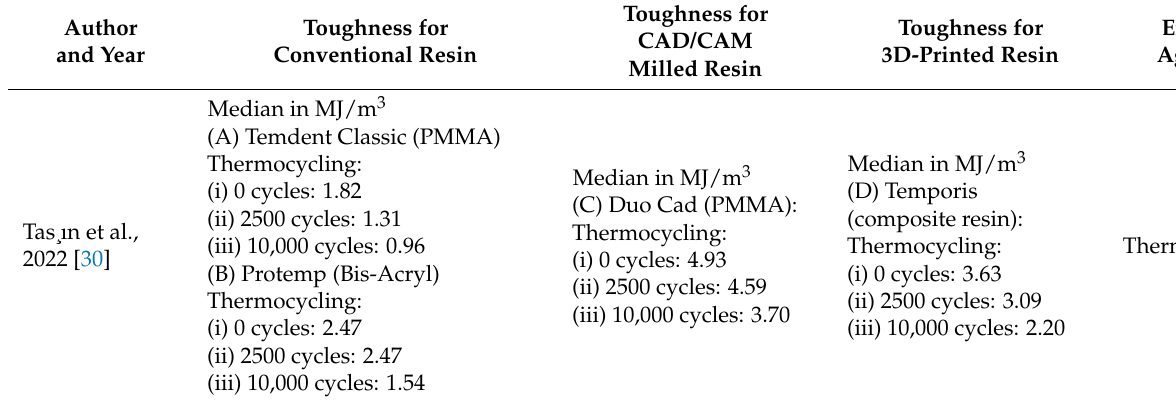
Table 13. Toughness Results (MJ/m 3